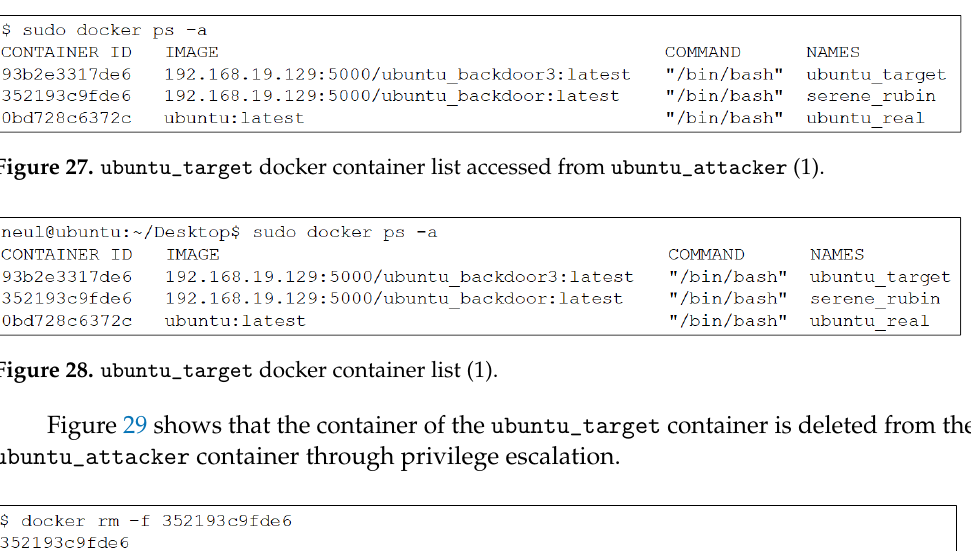
Figure 26. Privilege escalation attack success screen.